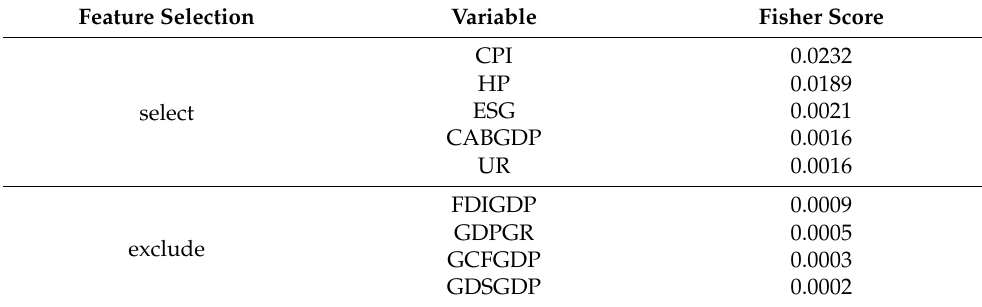
Table 5. Fisher Score.